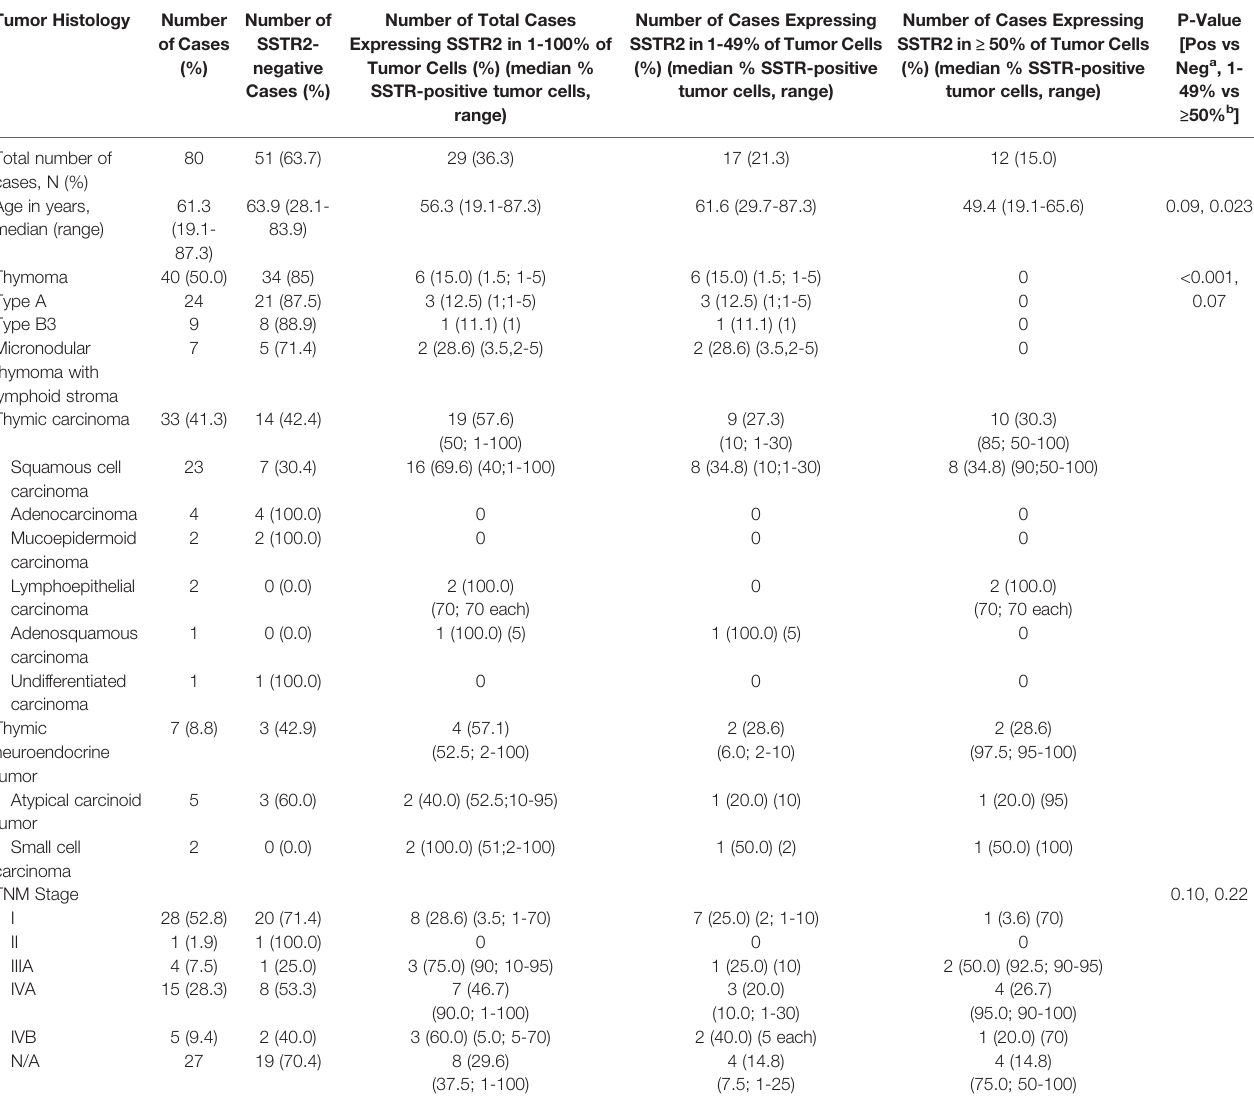
TABLE 2 | Histopathologic features and expression of SSTR2 in thymic epithelial tumors. Tumor